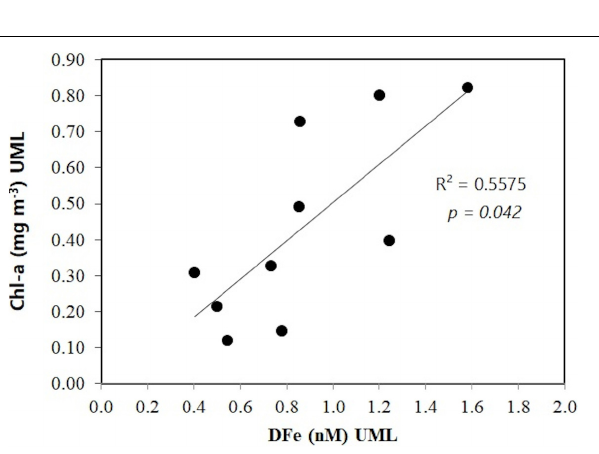
FIGURE 7 | Mean Chl-a (mg m − 3 ) in the UML relative to mean DFe (nM) in the UML in the SOI sector. SOI-coastal stations are not included.